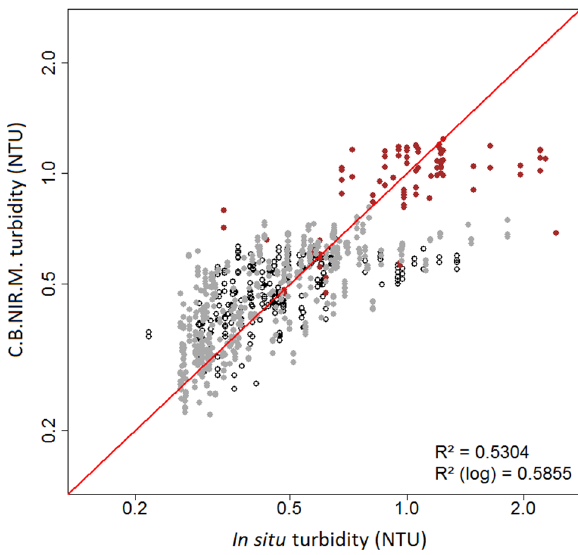
Figure 5. Log-linear regression between in-situ turbidity and remote sensing turbidity retrieved Figure 5. Log ‐ linear regression between in ‐ situ turbidity and remote sensing turbidity retrieved with with C.B.NIR.M. The red line is the first bisector. Only the high turbidity values (corresponding to C.B.NIR.M. The red line is the first bisector. Only the high turbidity values (corresponding to brown ‐ Figure 2. ( a ) Map of the bathymetry (in m) at the Voh ‐ Koné ‐ Pouembout (VKP) lagoon. Points colours brown-bottom stations) are not well retrieved by the SVR model. Points colours correspond to bottom Figure 2. ( a ) Map of the bathymetry (in m) at the Voh ‐ Koné ‐ Pouembout (VKP) lagoon. Points colours Figure 2. ( a ) Map of the bathymetry (in m) at the Voh ‐ Koné ‐ Pouembout (VKP) lagoon. Points colours bottom stations) are not well retrieved by the SVR model. Points colours correspond to bottom colour, colour, i.e., correspond to bottom colour, i.e. correspond to bottom colour, i.e. correspond to bottom colour, i.e.